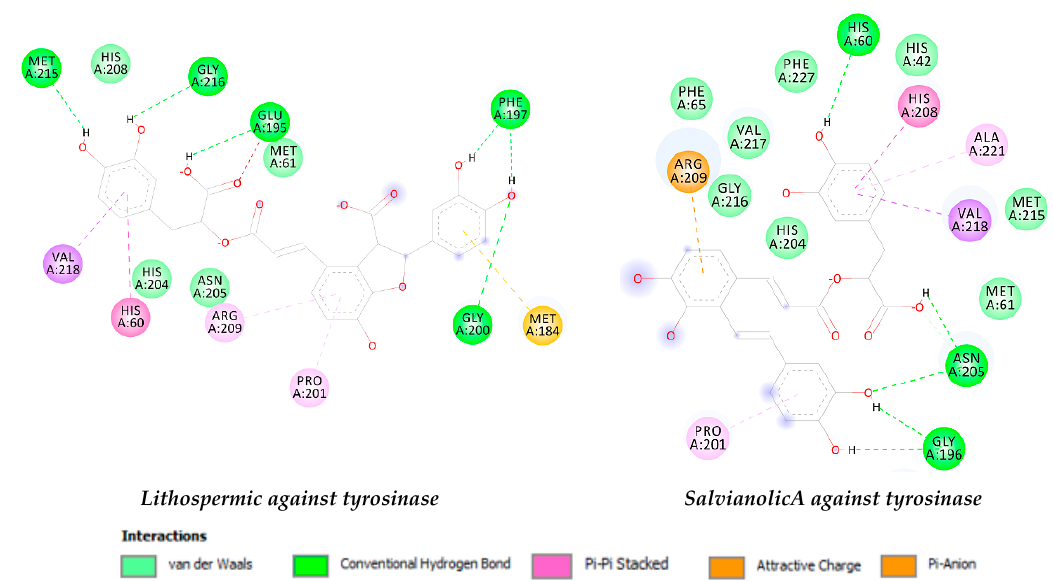
Figure 1. Intermolecular interactions of Lithospermic acid and Salvianolic acid A with the active site of the enzymes, α -amylase, acetylcholinesterase (AChE), butyrylcholinesterase (BChE), α -glucosidase, and tyrosinase enzymes. Table 5. Docking free energy in kcal/mol and the calculated inhibition constant of the selected compounds against α - amylase, AChE, BChE, α -glucosidase, and tyrosinase enzymes.